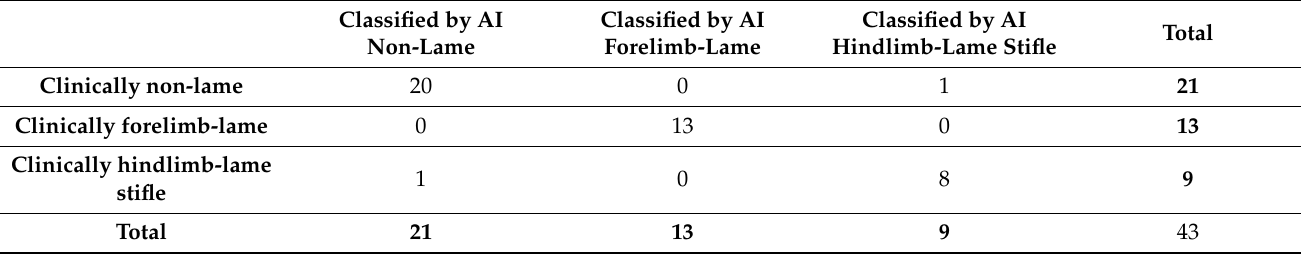
Table A3. 3 × 3-Table and statistical evaluation of κ (without reference point tuber